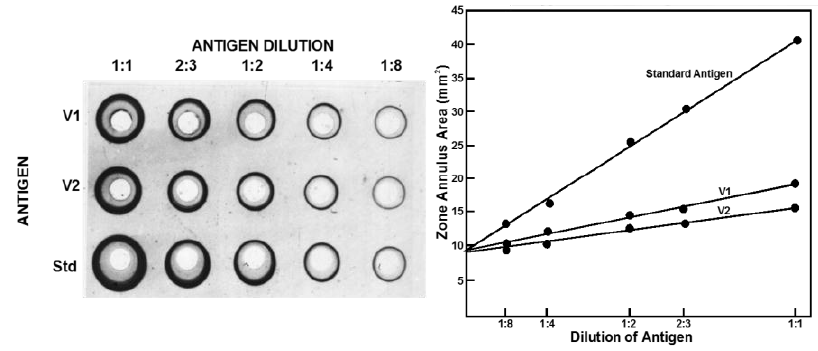
Figure 2. Single Radial Diffusion assay of influenza haemagglutinin. Stained plate showing zones and plot of zone size against dilution of analyte illustrating slope ratio statistical method for measuring